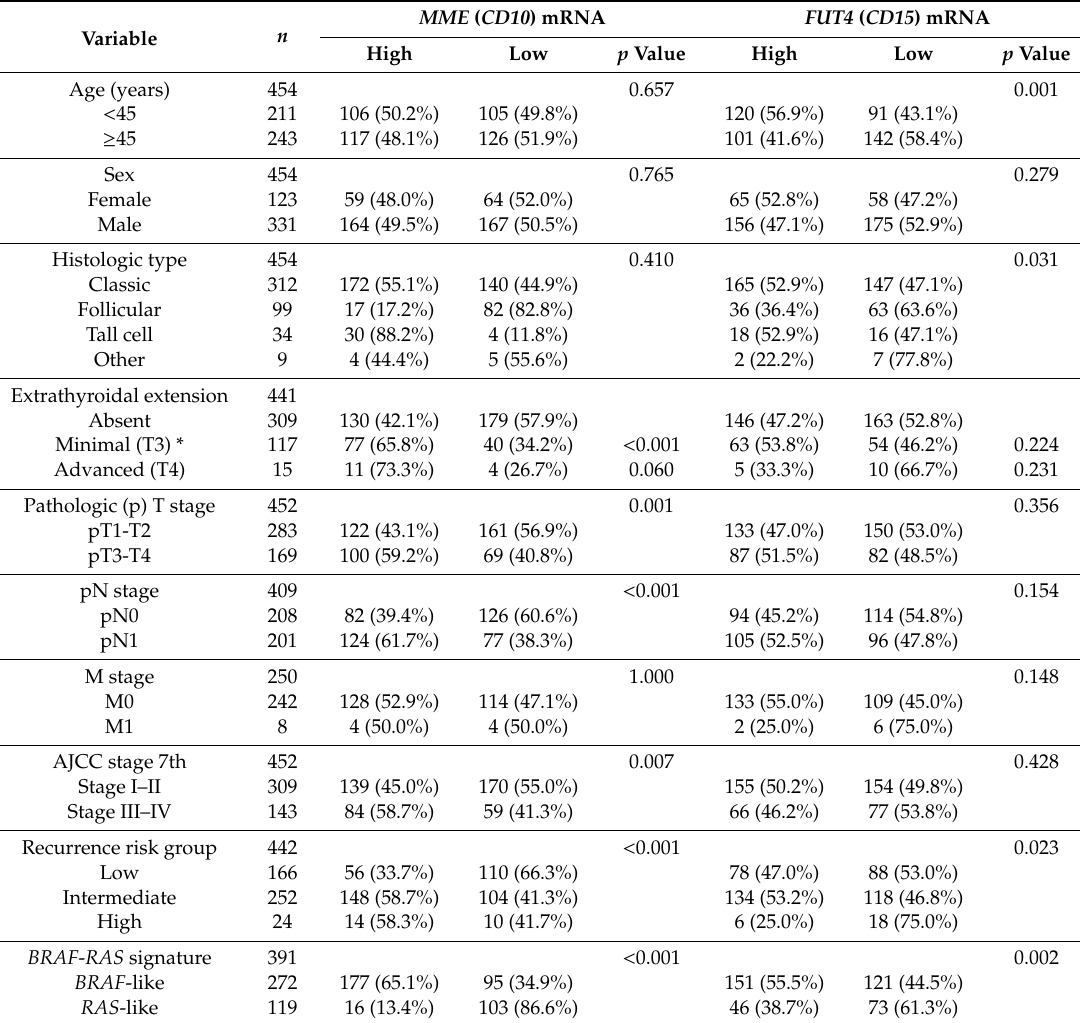
Table 4. Relationship between clinicopathologic characteristics and the expression of MME (CD10) and FUT4 (CD15) mRNA expression in 454 patients with papillary thyroid carcinoma in The Cancer Genome Atlas (TCGA)